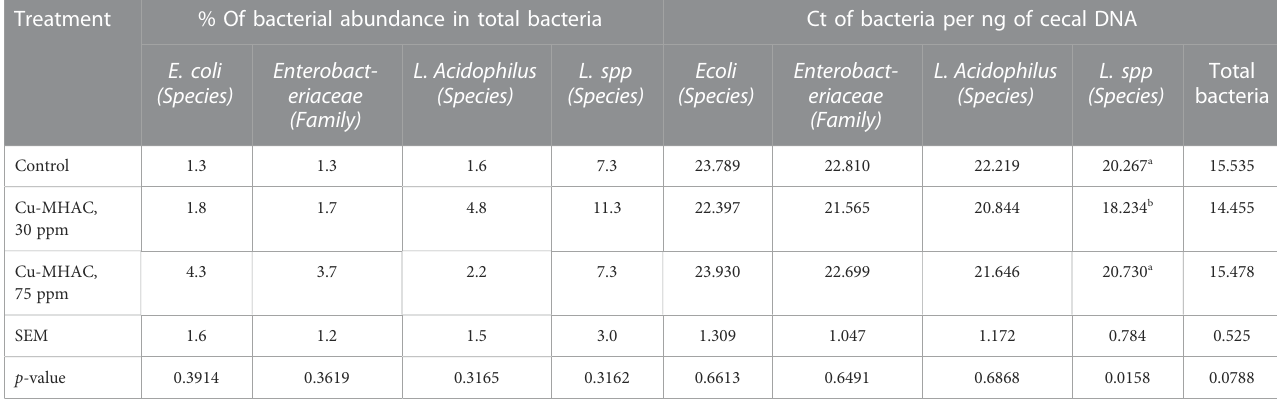
TABLE 8Ctof E. coli , Lactobacillusacidophilus , Lactobacillus spp .and Enterobacteriaceae per ng of cecal DNA, andpercentage (%) of E. Coli , LactobacillusL.)Acidophilus , L.spp . and Enterobacteriaceae (% of total bacteria) in cecum of broilers at 41 days of age of experiment #1. Treatment % Of bacterial abundance in total